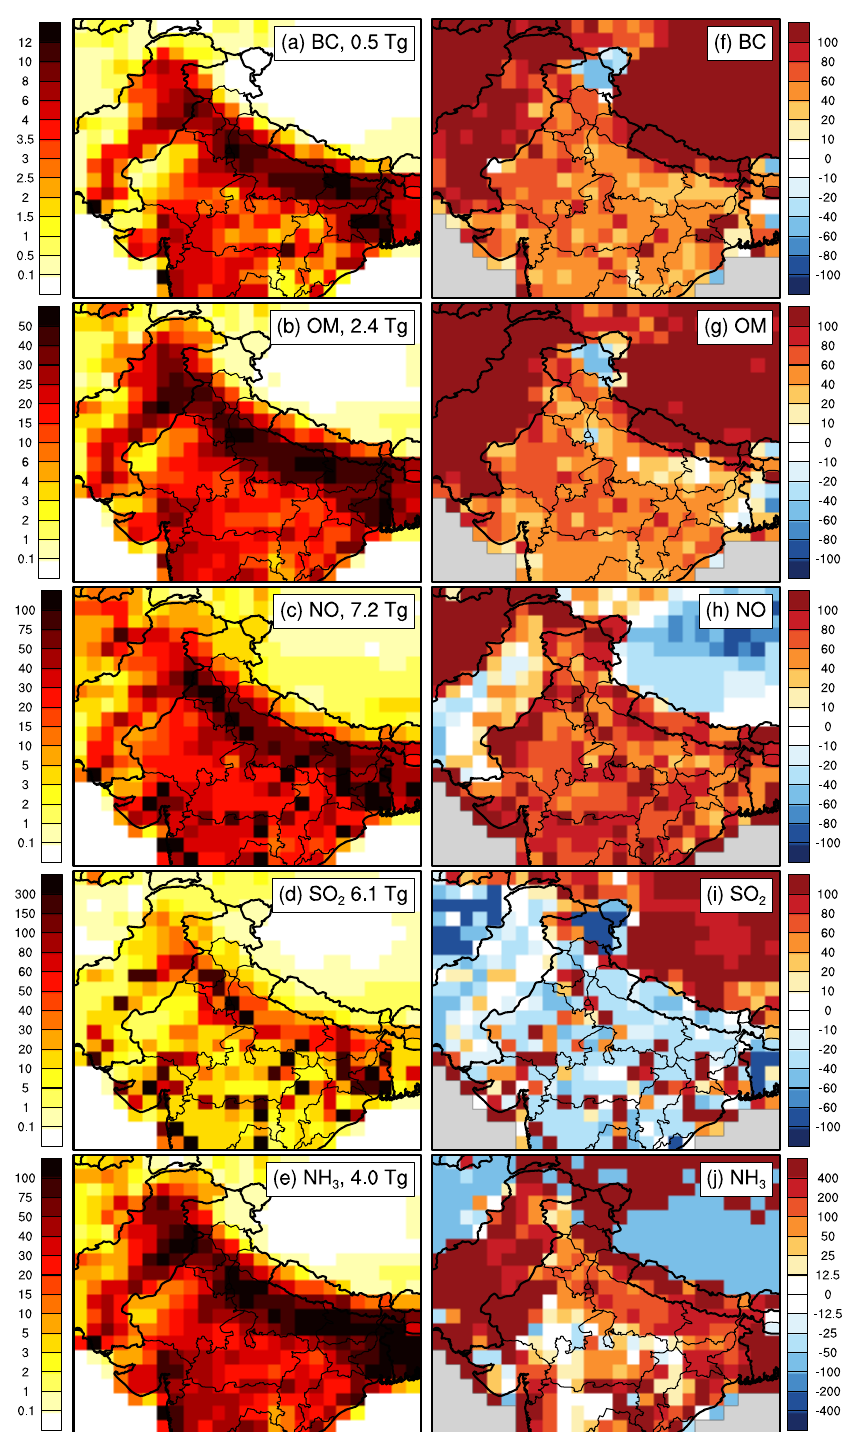
Figure 1. (a–e) Total CMIP6 anthropogenic emissions (Gg) of (a) black carbon (BC), (b) organic matter (OM), (c) NO, (d) SO 2 , and (e) NH 3 over 1 October 2015–31 March 2016. Total emissions over the domain (in Tg) are provided in the panel titles. (f–j) Difference (%) between CMIP6 and CMIP5 emissions (CMIP6 minus CMIP5) for the species in panels (a–e)